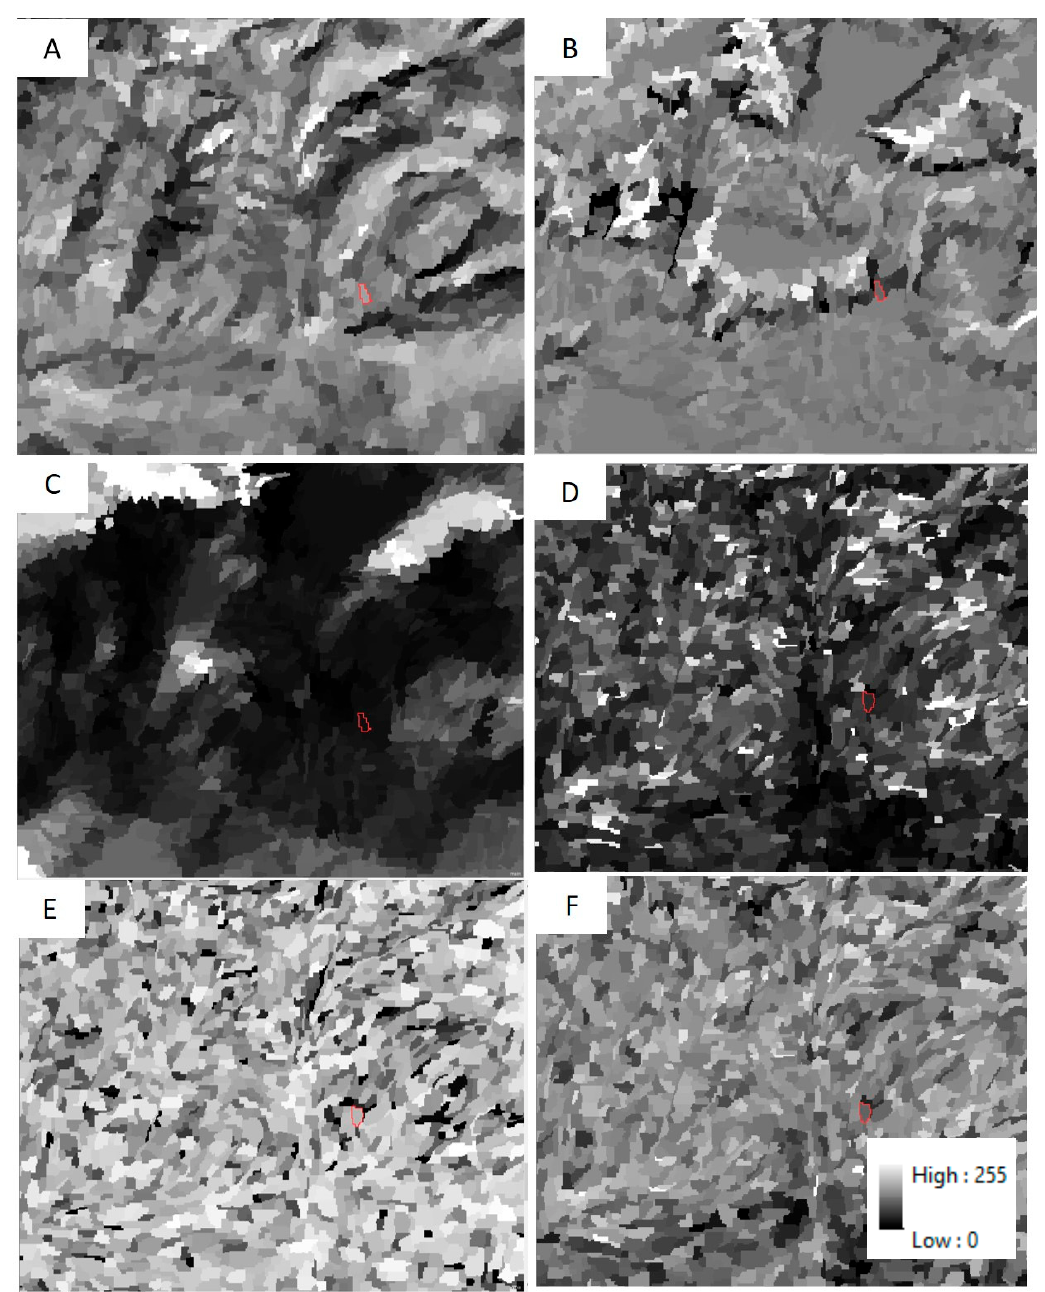
Figure 4. Representation of some of the selected object-based features that we applied for landslide detection and delineation, including ( A ) normalised di ff erence vegetation index (NDVI), ( B ) mean curvature, ( C ) mean flow direction, ( D ) grey level co-occurrence matrix (GLCM) contrast, ( E ) GLCM correlation, ( F ) GLCM standard